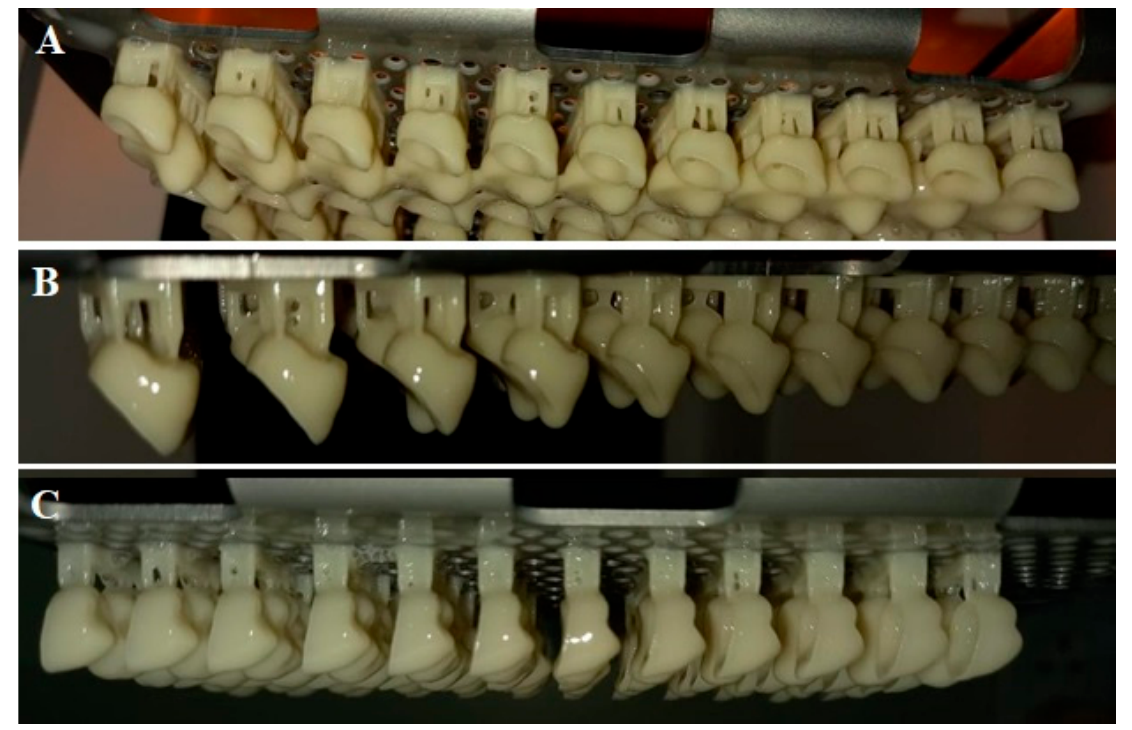
Figure 4. ( A – C ). The 3D-printed specimens with di ff erent orientations for NextDent ( A ) 0-degree, ( B ) 45-degree, and ( C ) 90-degree (scale bar 5 mm).